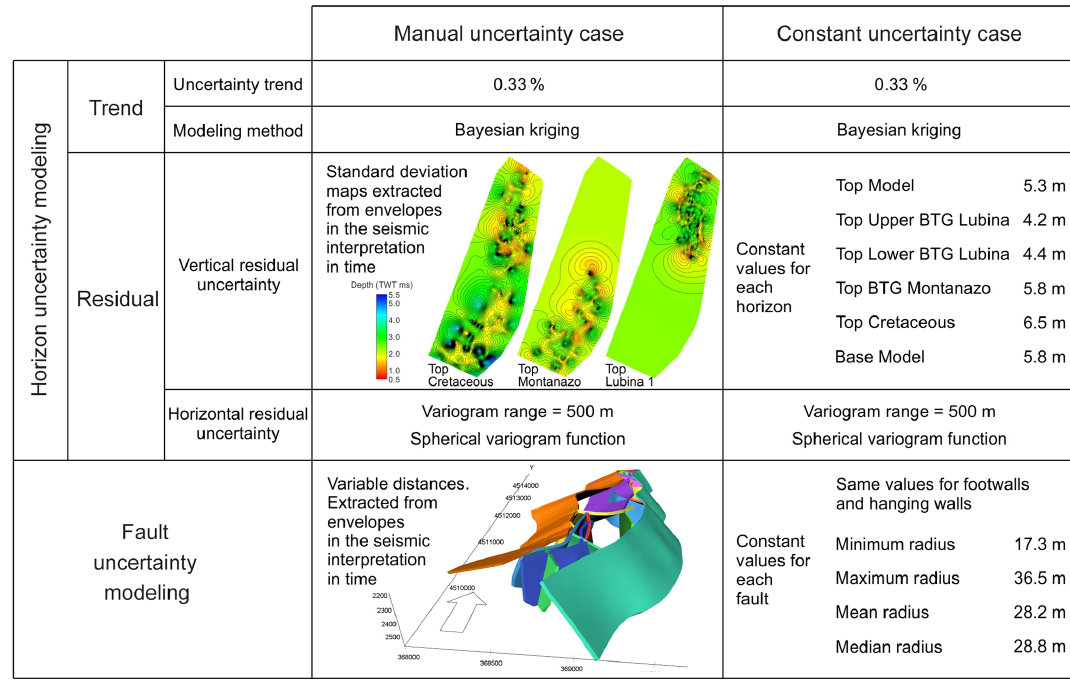
Figure 5. Parameters, values and methods used in the manual and constant uncertainty cases to capture the horizon and the fault uncertainties.